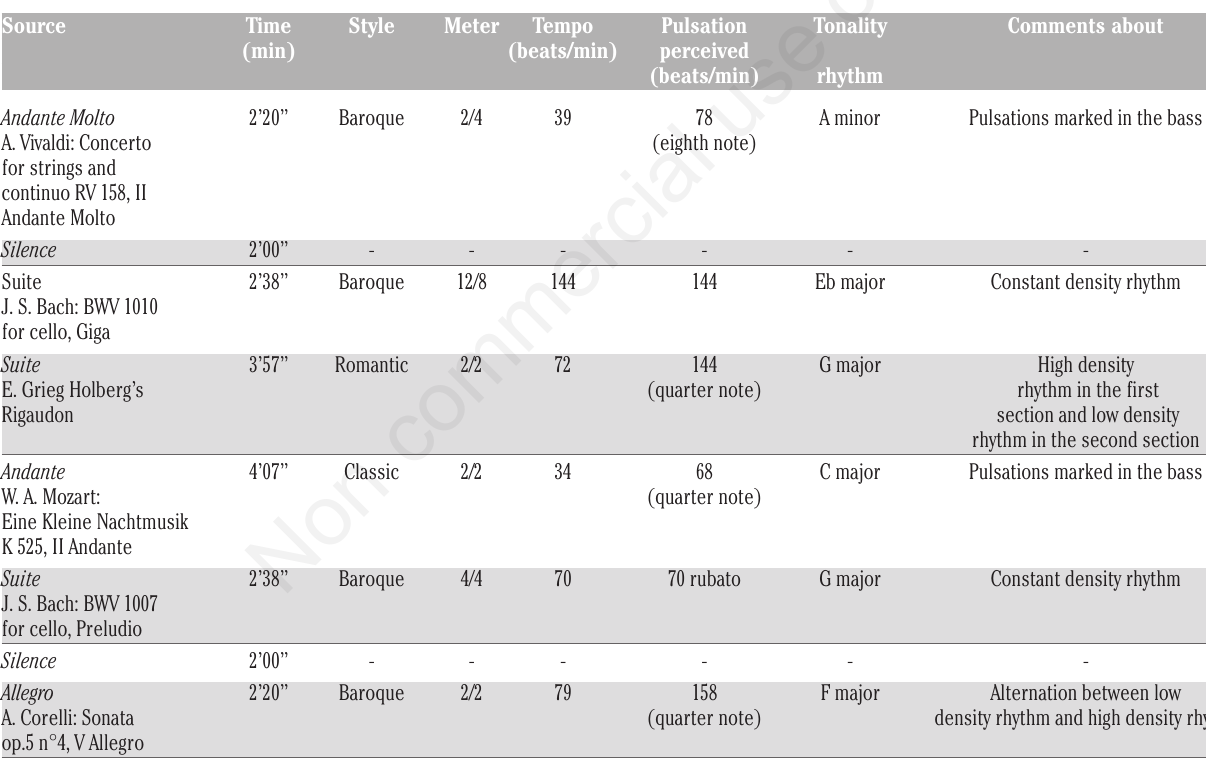
Table 1. Characteristics of music tracks.